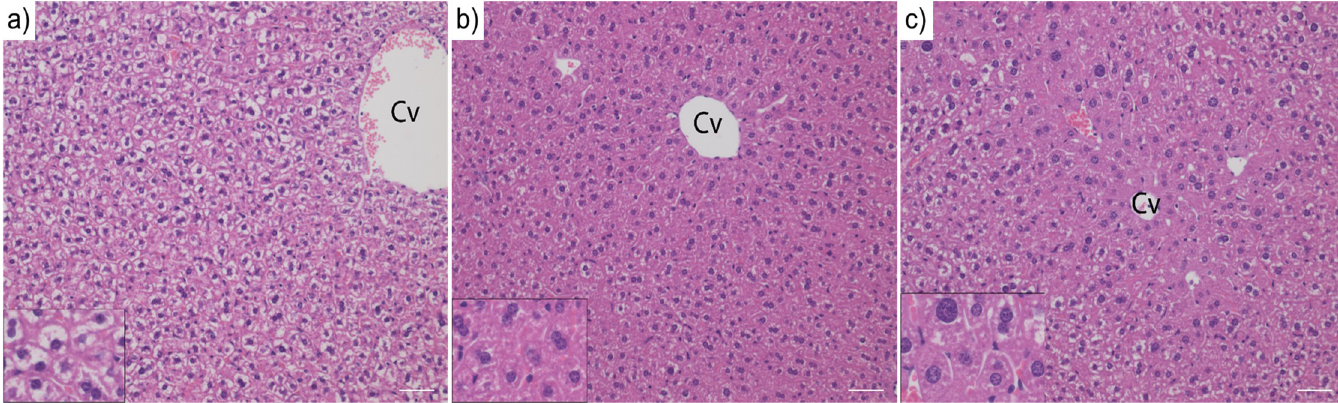
Fig 3. Hepatic morphology. Representative hepatic morphology of 9-week-old female offspring maternally exposed to a mixture of POPs at Control (a), Low (b) or High (c) doses (0x, 5000x or 100 000x human estimated daily intake, respectively). Hepatocytes have increased size and frequently enlarged hyperchromatic nuclei, which were graded on a scale from 0 to 4 (0 = no, 1 = minimal, 2 = mild, 3 = moderate, and 4 = severe change). The Low (b) and High (c) doses exhibited mild and severe hypertrophy, respectively, compared to the normal morphology of the Control (a). Magnification at 200-fold (inset at 400-fold). Scale bar = 50 μ m. Cv = Central vein.